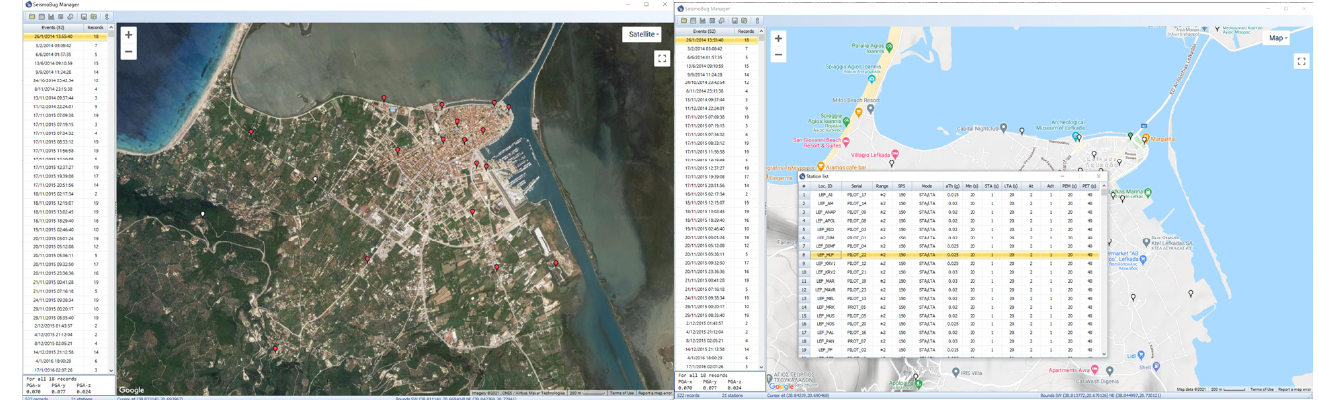
Figure 6. The SeismoBug © Manager software.